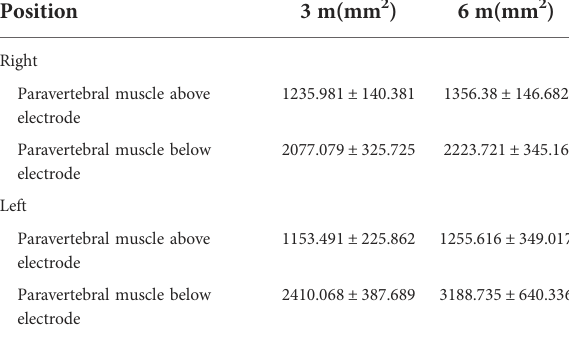
TABLE 1 Cross-sectional areas of paravertebral muscles.